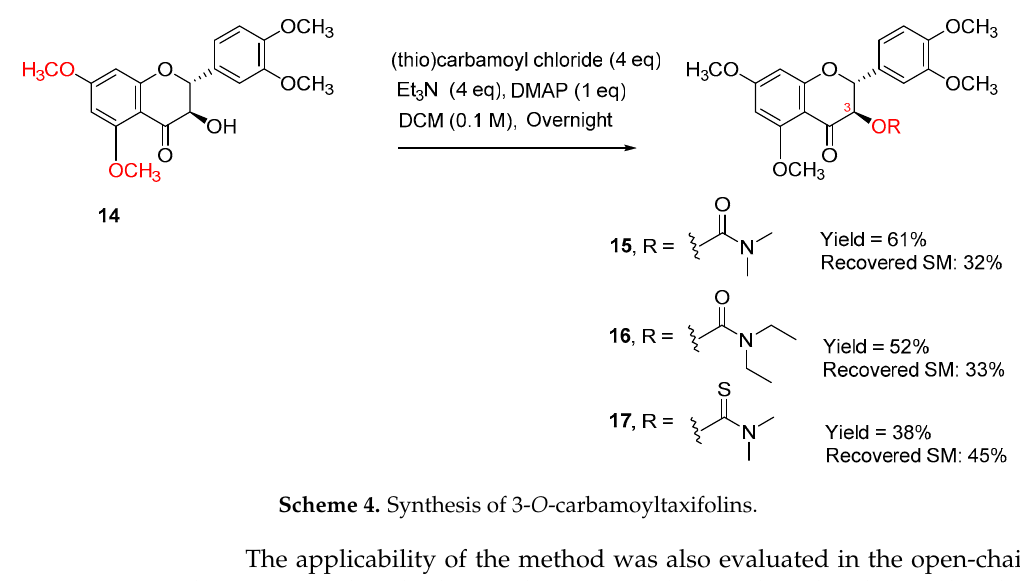
Scheme 5. Carbamoylation of open-chain α -hydroxyl ketones.